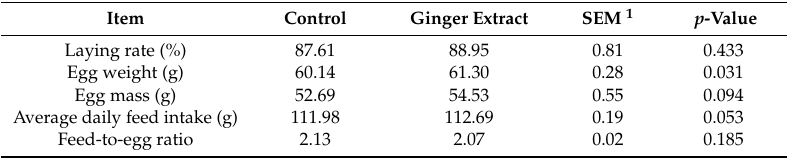
Table 2. E ff ects of ginger extract on performance of laying hens.